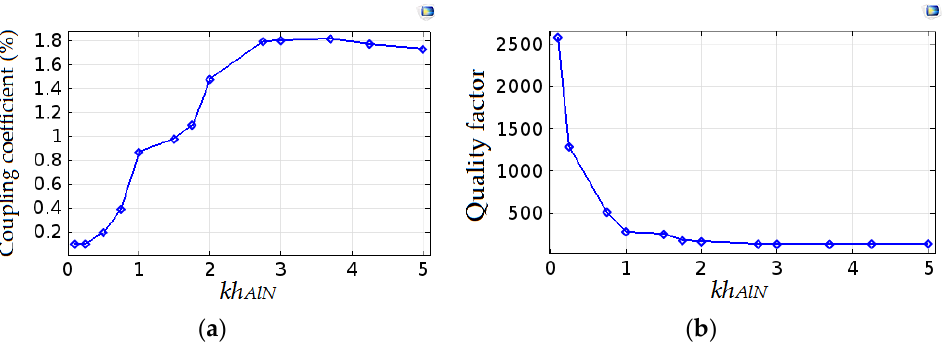
Figure 5 . ( a ) Dispersion curves of electromechanical coupling coefficient as a function of kh AlN , ( b ) Dispersion curves of the quality factor versus kh AlN.